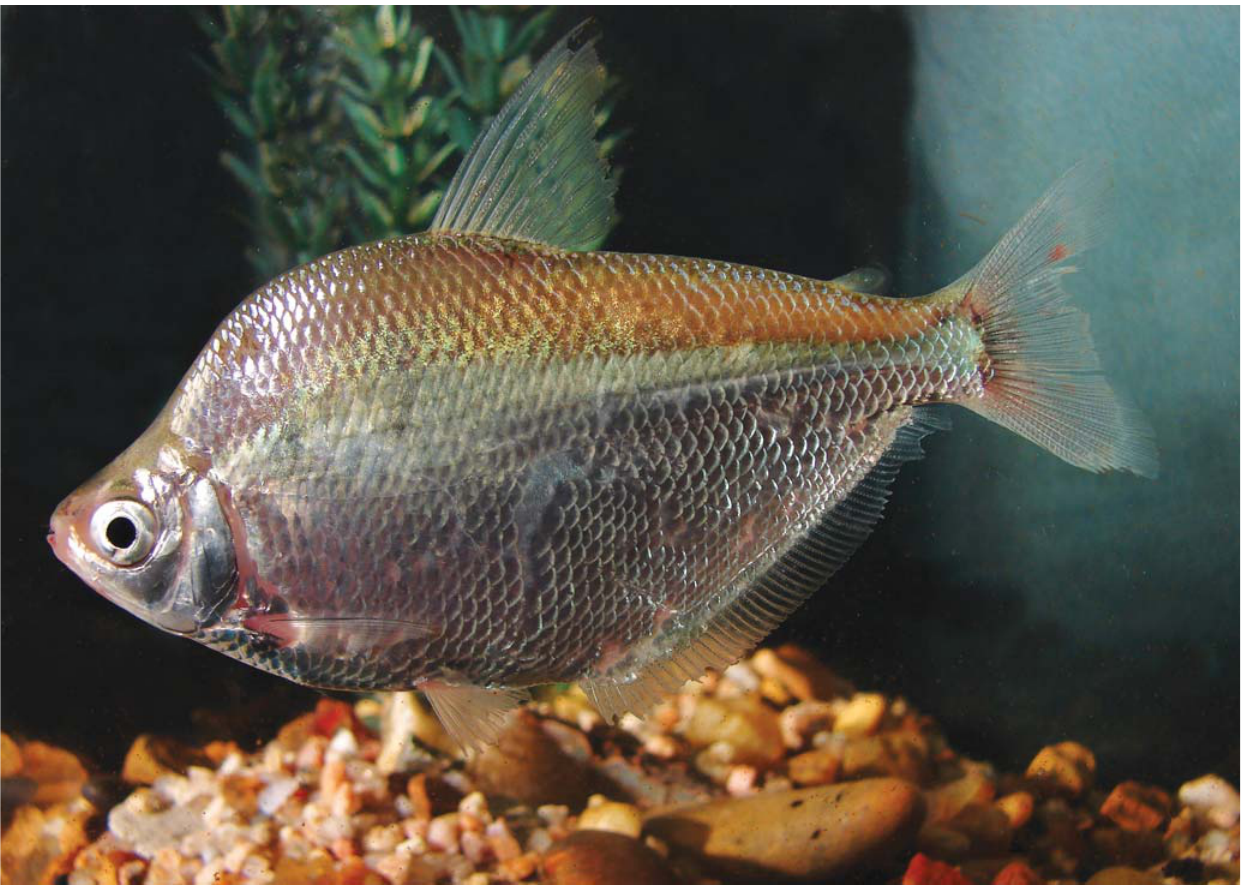
Fig. 2. Astyanax erythropterus (adult), MACN-ict 9455, 89.3 mm SL, Argentina, Provincia de Entre Ríos, Parque Nacional Pre- Delta, río Paraná basin Rowing Club, mouth of the Arroyo La Ensenada. Photographed in